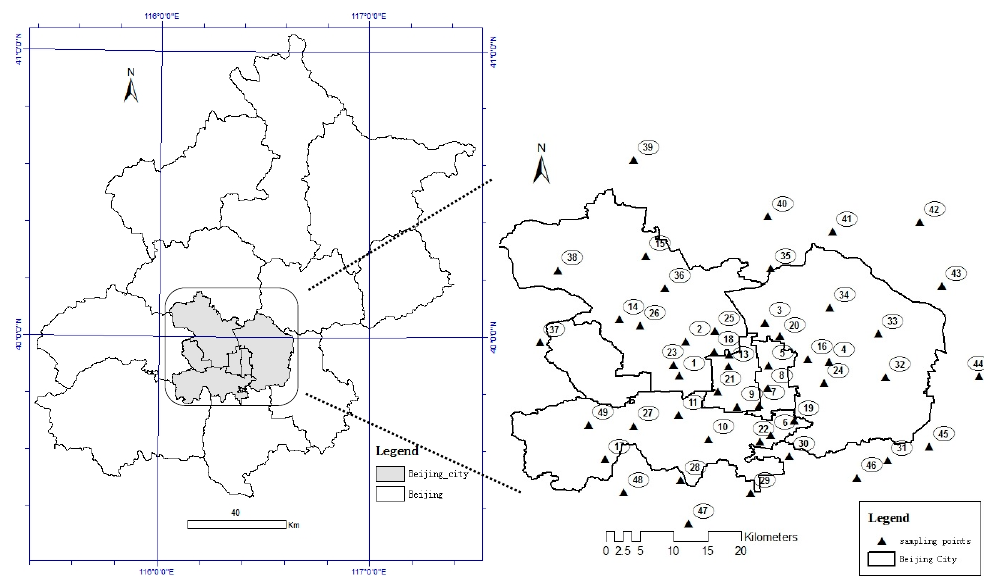
Figure 1. Geographic location and dust sampling points in the metropolitan area of Beijing, China.